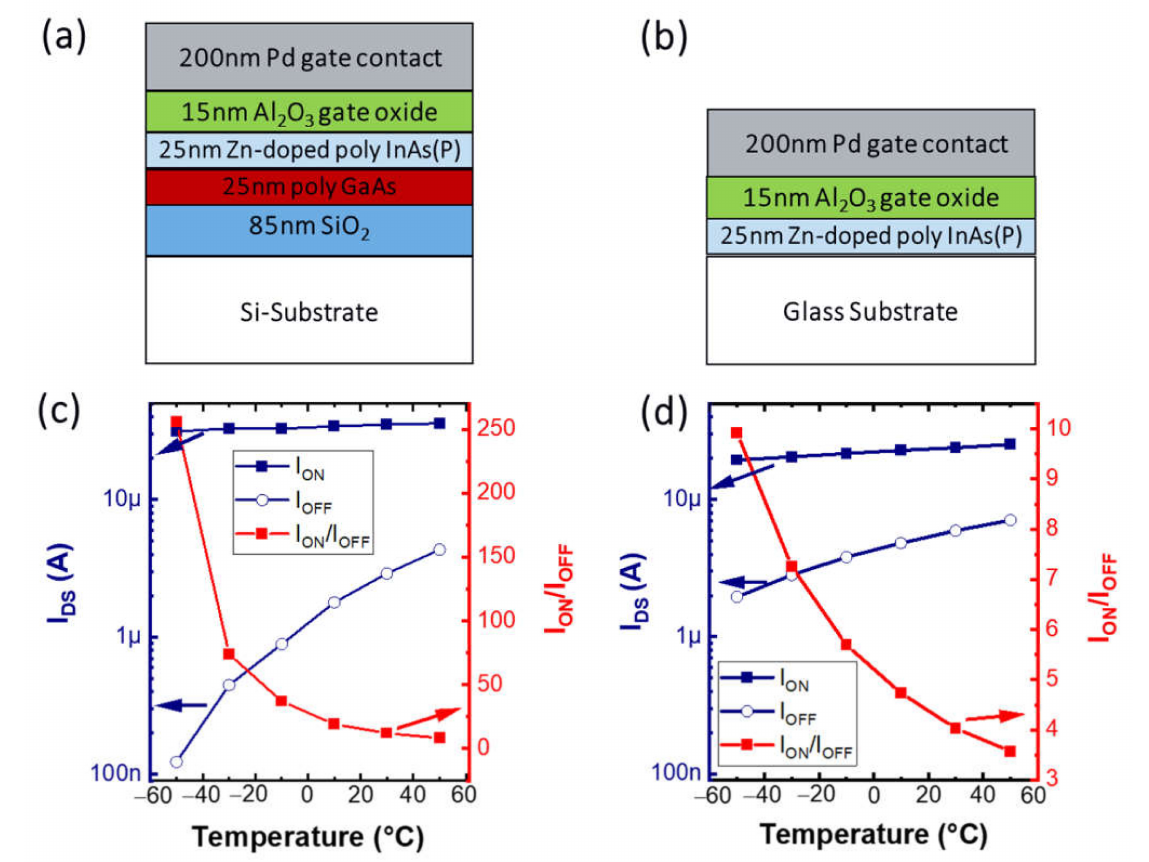
Figure 5. Schematic structure of ( a ) sample with GaAs/InAs heterostructure on Si/SiO 2 and ( b ) sample with InAs directly on glass. ( c ) I ON , I OFF , and I ON /I OFF vs. temperature for sample in Figure 6a, ( d ) I ON , I OFF , and I ON /I OFF ratio vs. temperature for sample in Figure 6b. V DS = 1.5 V, I ON was taken at V GS = 5 V, and I OFF was taken at V GS = − 5 V for Figure 4c,d.